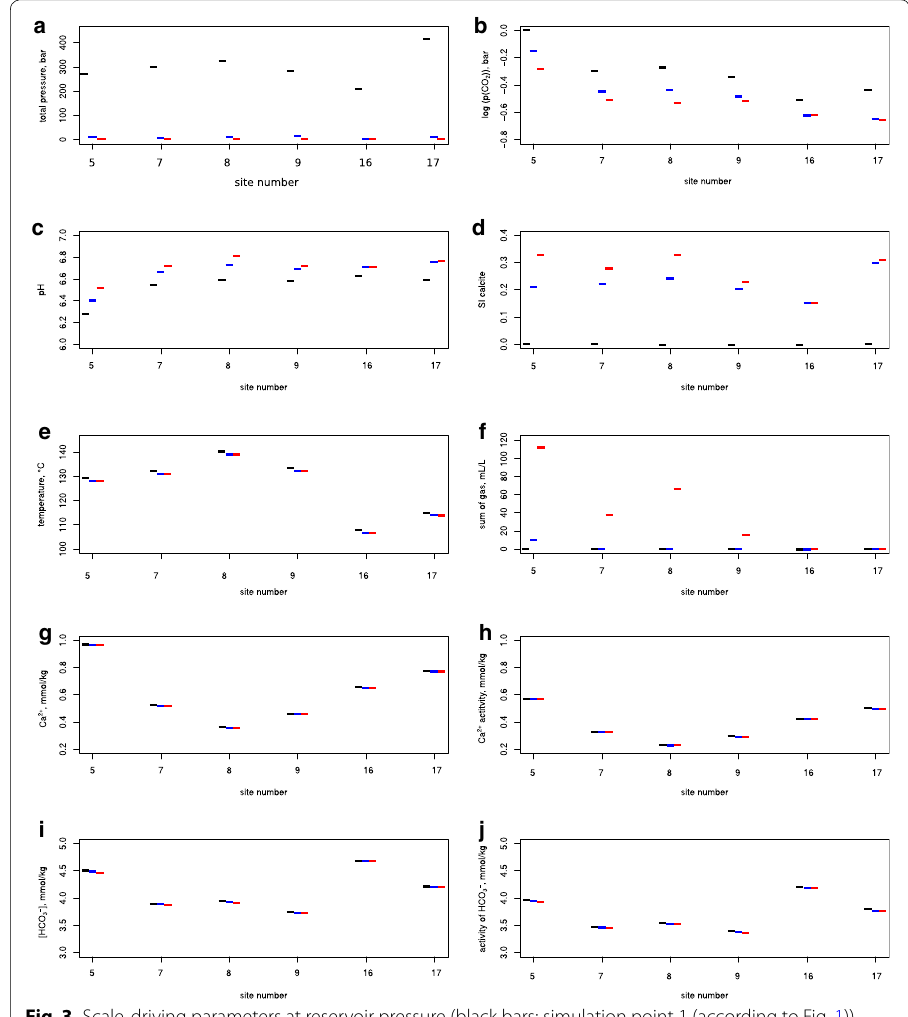
Fig. 3 Scale-driving parameters at reservoir pressure (black bars: simulation point 1 (according to Fig. 1)), at standardized wellhead pressure at 5 bar (red bars: simulation point 5), and at real wellhead pressure at 5–14 bar (blue bars: simulation point 5). X-axis shows site number. a total pressure, b logarithmic partial pressure of CO 2 , c pH, d SI calcite , e temperature, f sum of free gas phase, g calcium ion concentration, h calcium ion activity, i bicarbonate ion concentration, k bicarbonate ion